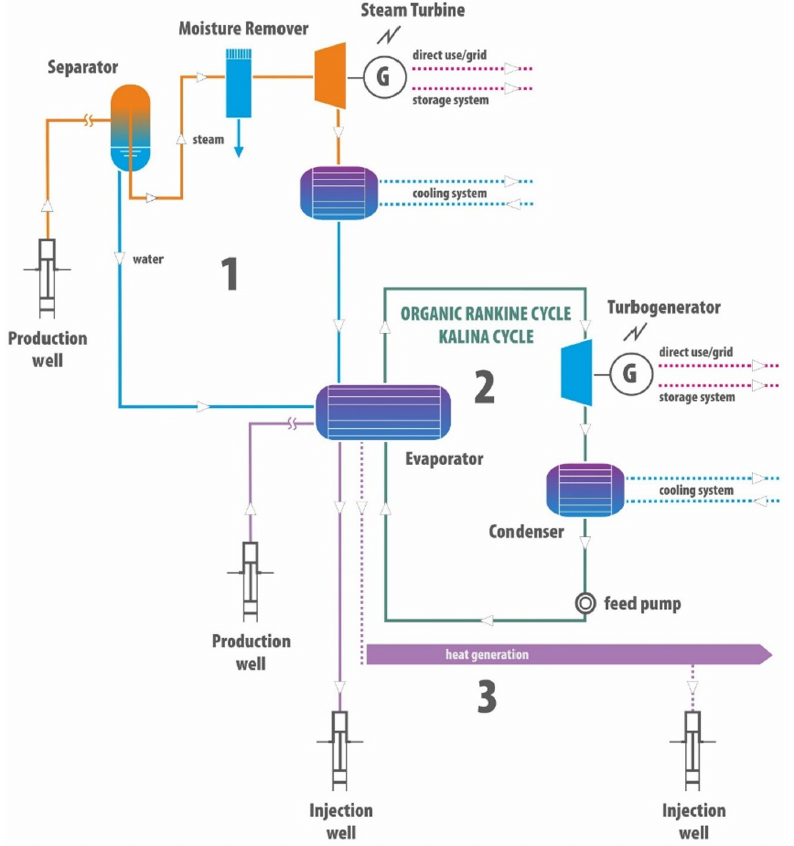
Figure 4. A simple illustration of using geothermal resources for the production of electricity and heat for MD processes [84]. Image reused under the Creative Commons license.